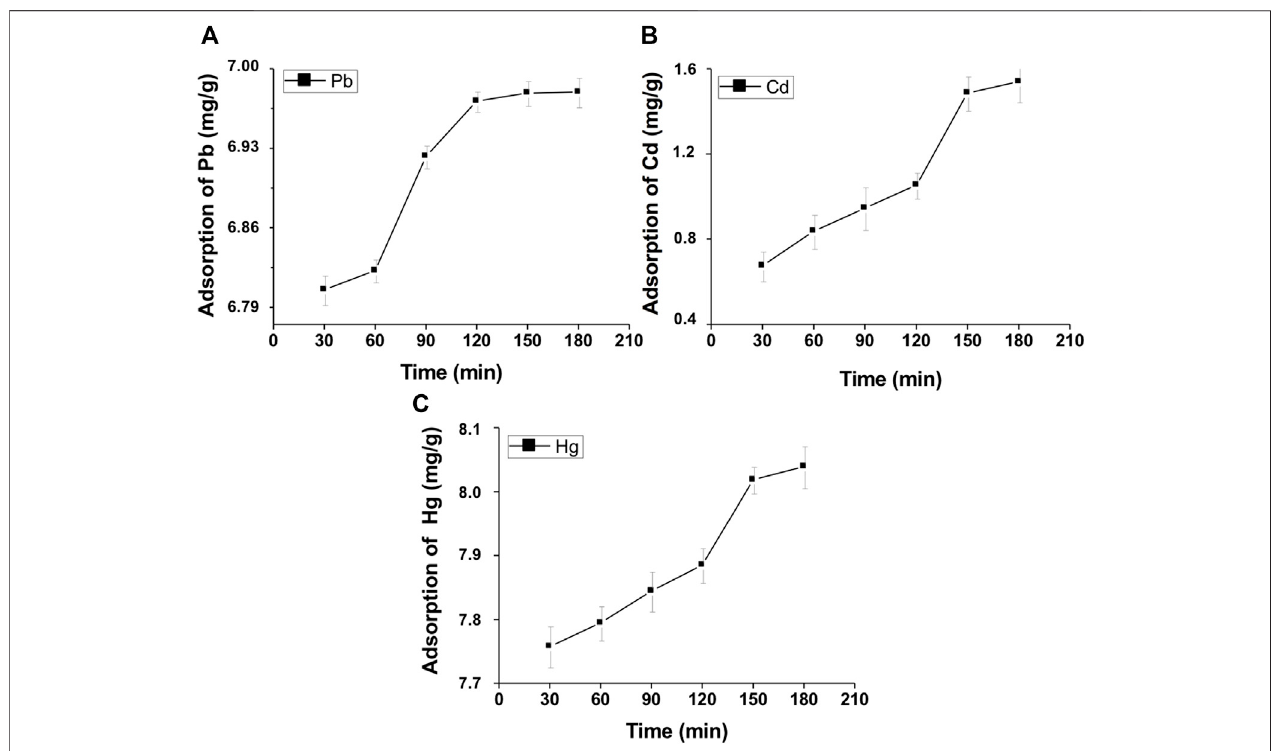
Frontiers in Environmental Chemistry |